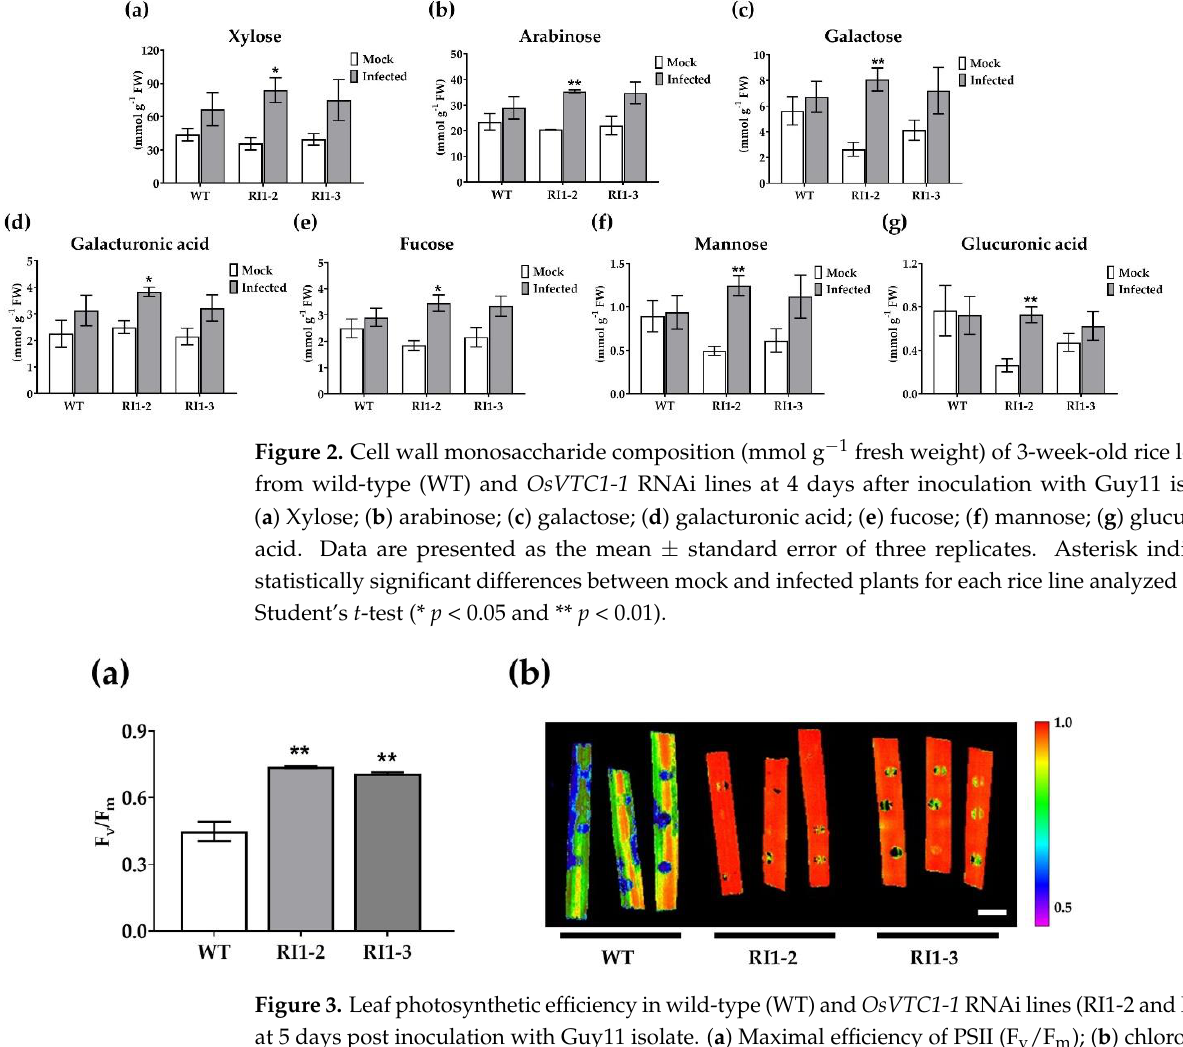
Figure 3. Leaf photosynthetic efficiency in wild-type (WT) and OsVTC1-1 RNAi lines (RI1-2 and RI1-3) at 5 days post inoculation with Guy11 isolate. ( a ) Maximal efficiency of PSII (F v /F m ); ( b ) chlo- rophyll fluorescence image showing photosynthetic activity across the leaf surface (scale bar = 1 cm). Data are presented as the mean ± standard error of three replicates. Asterisk indicates statisti- cally significant differences from WT analyzed using Student’s t -test (** p < 0.01).